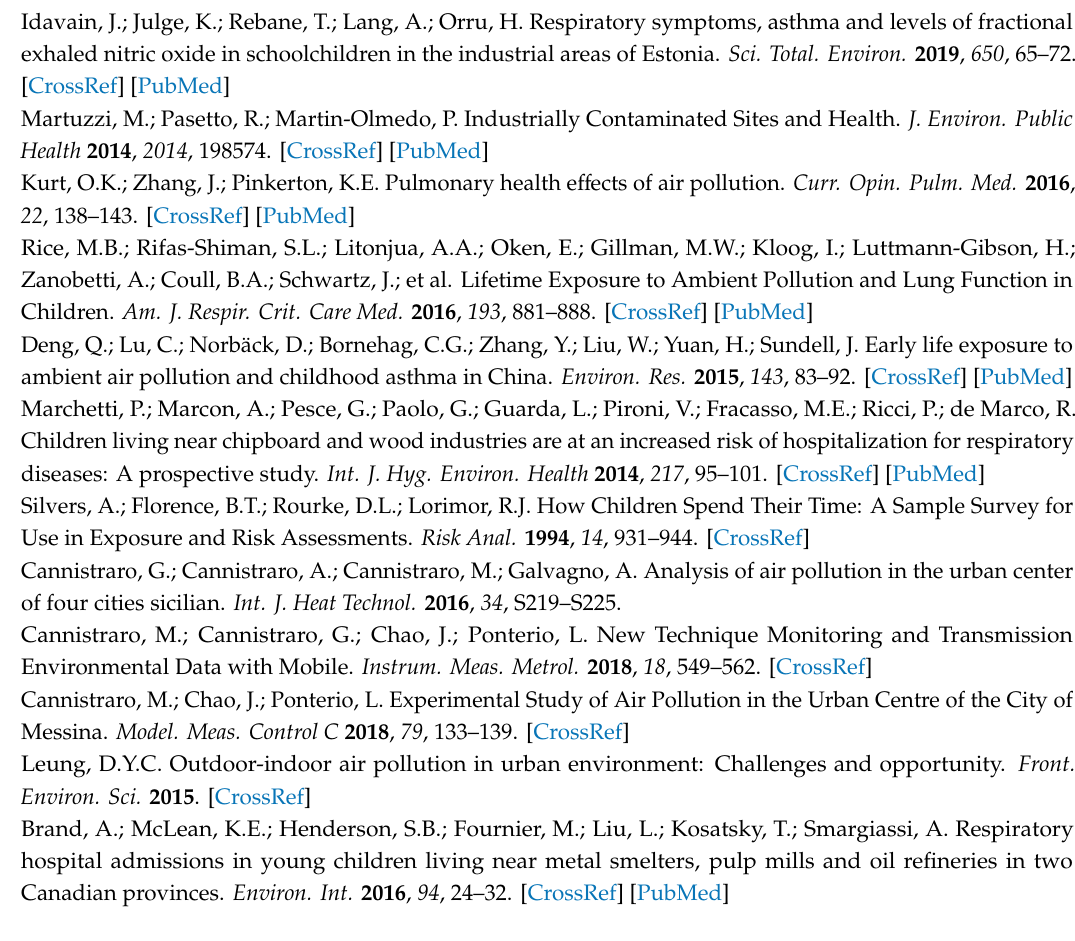
Table S1: Descriptive statistics of 24-h average concentration of indoor air pollutants in the houses of tra ffi c, industry, and general